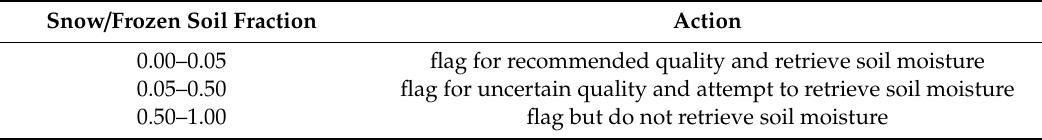
Table 1. Flagging actions per snow / frozen soil fraction for Soil Moisture Active / Passive (SMAP)